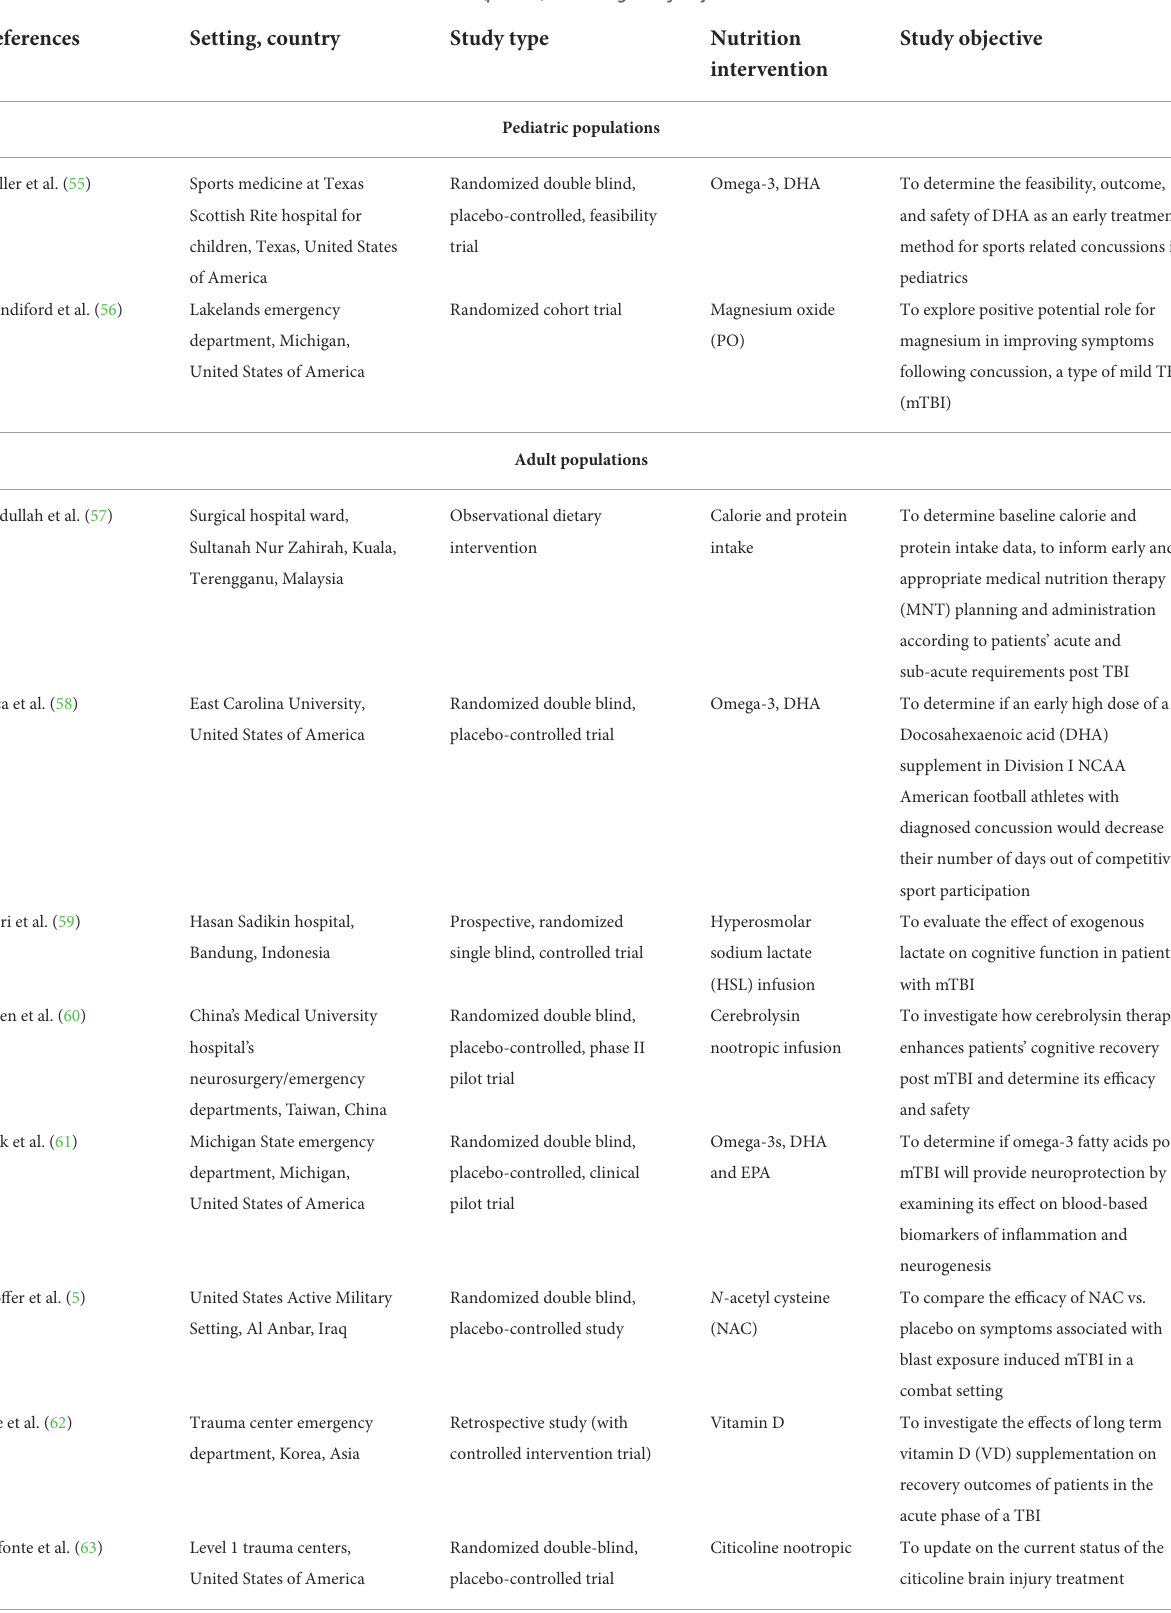
TABLE 2 Characteristics of the studies included in the review ( p = 11) including study